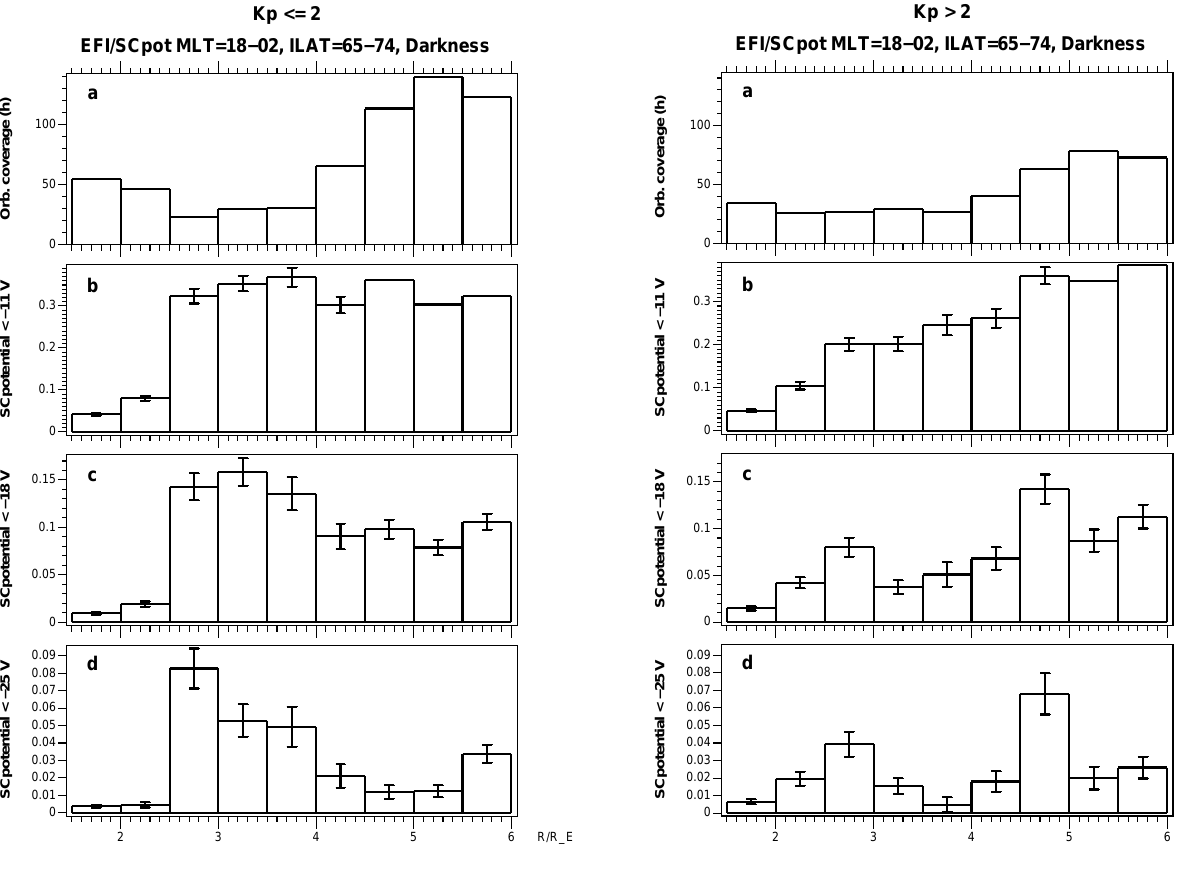
Fig. 1. Occurrence frequency of auroral cavities as determined from 5 years of Polar EFI spacecraft potential data in the 18–02MLT range for conditions when the ionospheric footpoint is in darkness. Left plot is for K p ≤ 2 and right plot for K p > 2. The top panel is the orbital coverage in hours while the remaining panels give the occurrence frequency for spacecraft potential thresholds − 11V, − 18V and − 25V. The horizontal axis is the radial distance from 1.5 to 6 R E